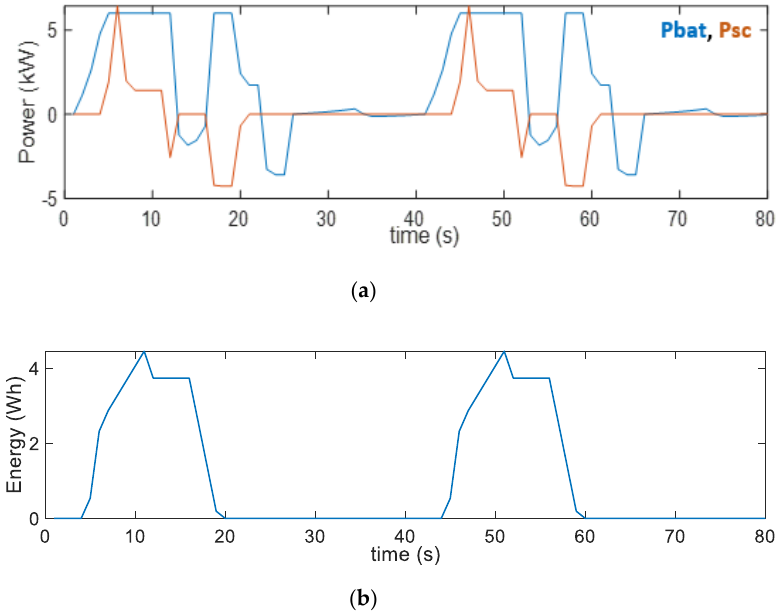
Figure 10. ( a ) Battery power limitation with supercapacitor energy supervision (battery power in blue, supercapacitor power in red). ( b ) Supercapacitor energy.